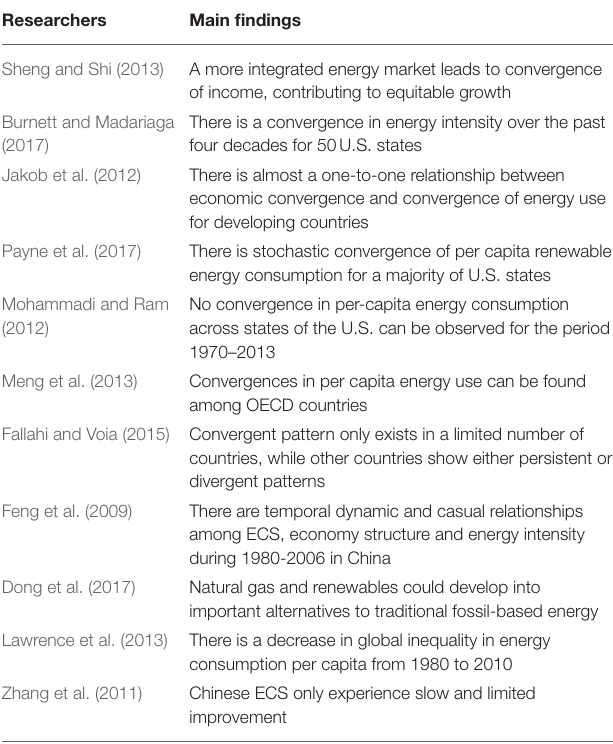
TABLE 1 | Major recent findings of relevant literature in this